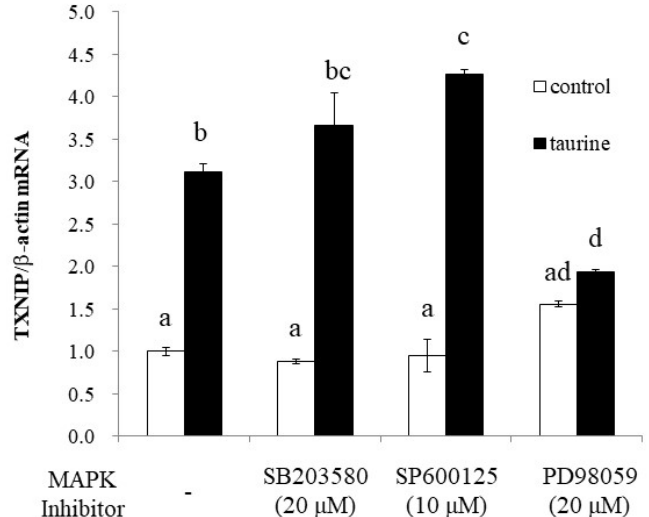
Figure 9. Effect of MAP kinase inhibitors on the taurine-induced increase in TXNIP mRNA in Caco-2 cells. Caco-2 cells were pretreated with each of the three MAPK inhibitors for 2 h and then cultured in medium containing 100 mM of taurine and each inhibitor. After 48 h, RNA was extracted and used for real-time PCR. The results are expressed as relative values, with the control value without the inhibitor as 1. Each value is the mean ± S.E. ( n = 3) and the abcd values indicated by different characters are significantly different from each other, and the abcd values indicated by the same characters are not significantly different (Tukey’s test; p < 0.05).